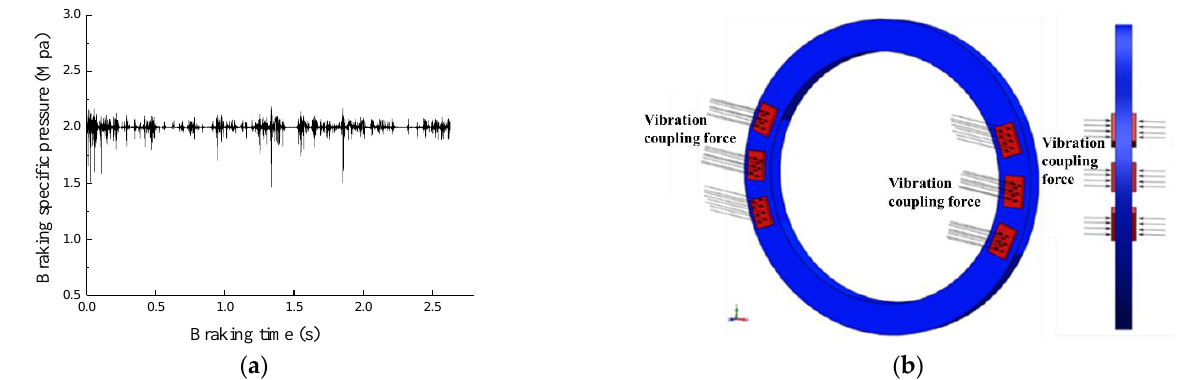
Figure 8. Emergency braking model of a brake shoe under vibration conditions.